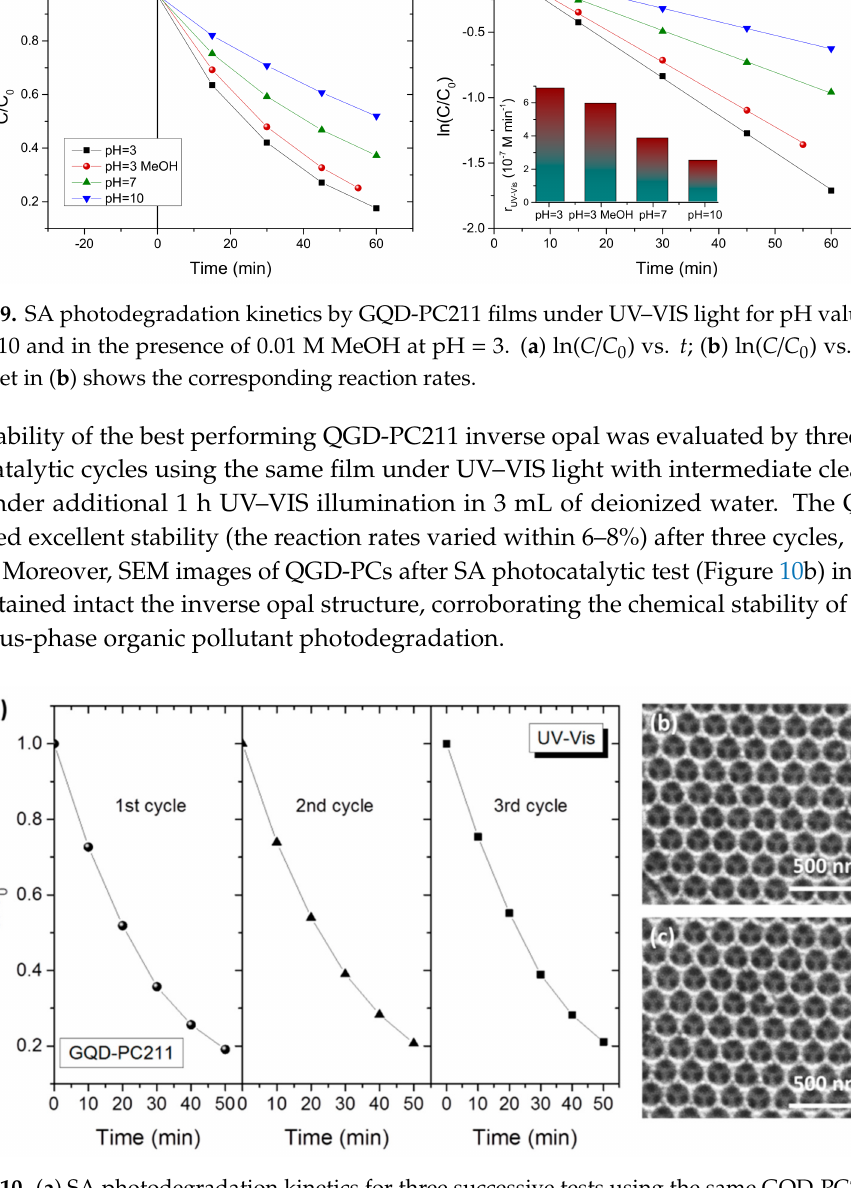
Figure 10. ( a ) SA photodegradation kinetics for three successive tests using the same GQD-PC211 film under UV–VIS light; SEM images of GQD-PC261 ( b ) before and ( c ) after SA